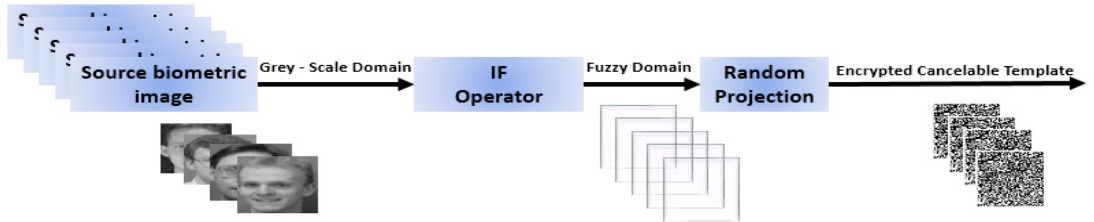
Figure 3. Proposed CFR framework based on intuitionistic fuzzy logic and Random Projection (RP) (i.e., CFR1).